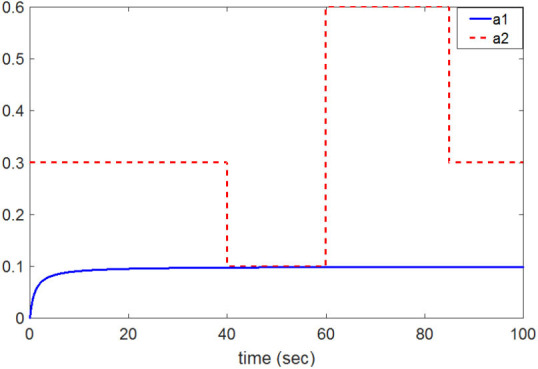
Change of time-varying parameters a1 and a2.